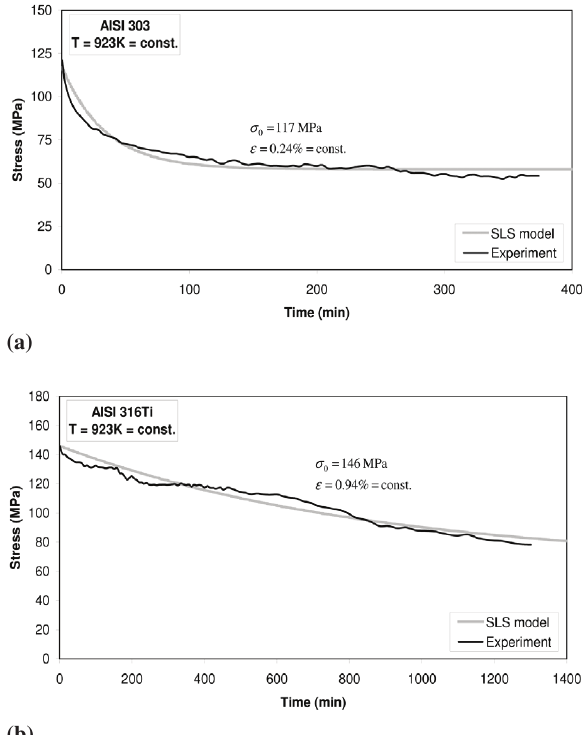
Figure 8. Experimentally obtained and modeled relaxation curves: AISI 303 steel and AISI 316Ti steel, temperature T D 923 K, stress at the beginning of the relaxation (cid:2) 0 . (a) AISI 303 steel, (cid:2) 0 D 117 MPa. (b) AISI 316Ti